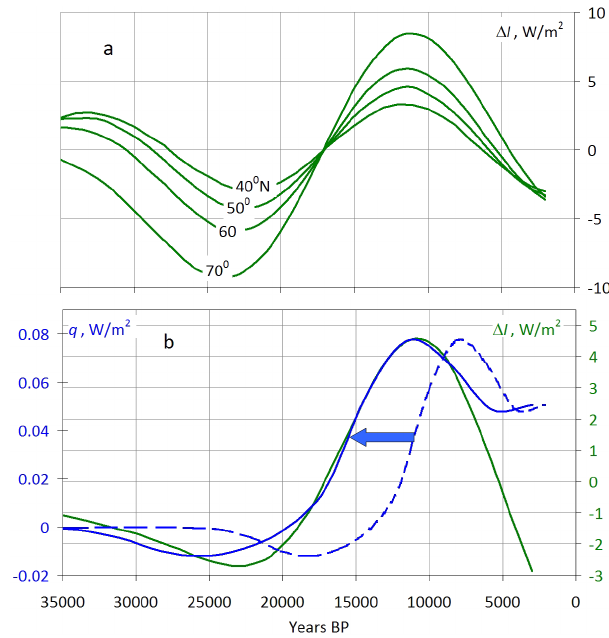
Figure 3. The comparison of SHF history with solar insolation changes in the Northern Hemisphere caused by changes in Earth’s orbital parameters and timescale correcting. (a) Annual insolation changes (cid:49)I ( t ) at the latitudes of 40–70 ◦ N (Berger and Loutre, 1991); (b) annual solar insolation at the latitude of 60 ◦ N smoothed in uneven running windows (green line), SHF history in the initial timescale ( a = 1 . 0 × 10 − 6 m 2 s − 1 , blue dashed line) and SHF his- tory in the corrected timescale ( a = 0 . 71 × 10 − 6 m 2 s − 1 , blue solid line).